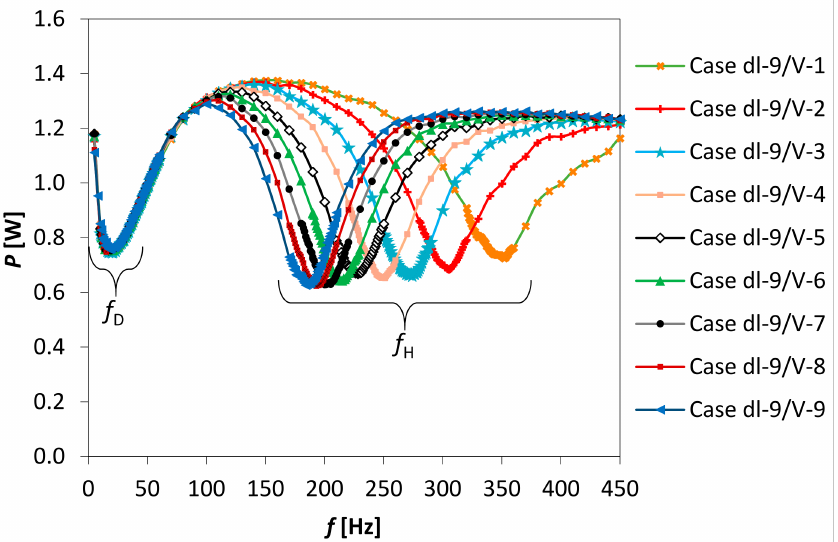
Figure 4. Dependence of SJA apparent power on excitation frequency for effective voltage E = 3